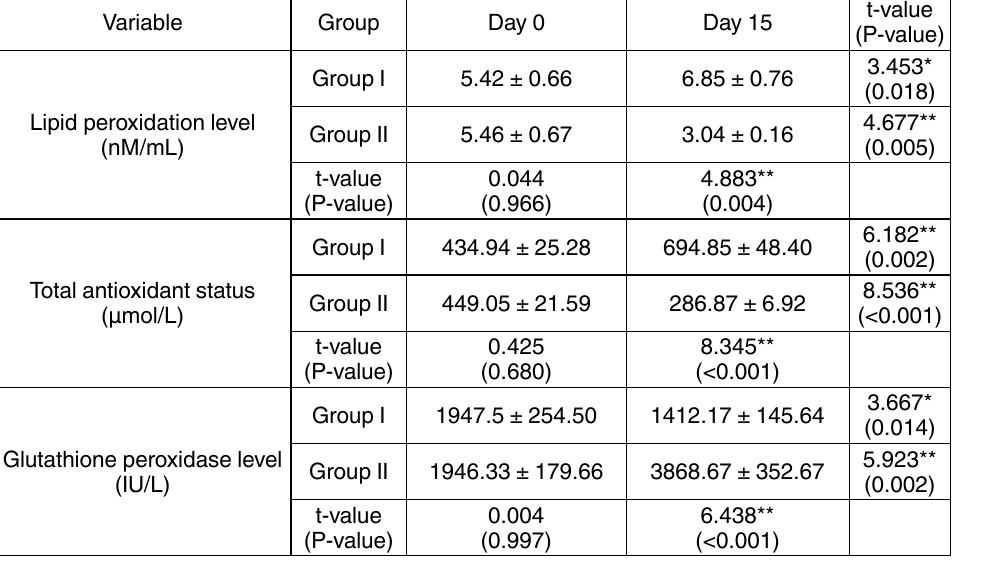
table 2. Comparison of oxidative stress parameters between groups and between days 0 and